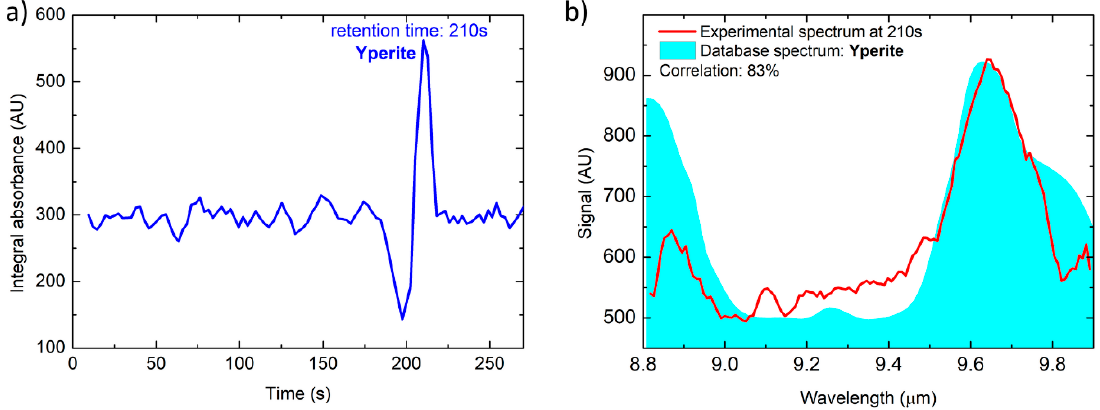
Figure 10. Total absorption chromatogram ( a ) and sulfur mustard HD spectrum acquired at T = 210 s ( b ).